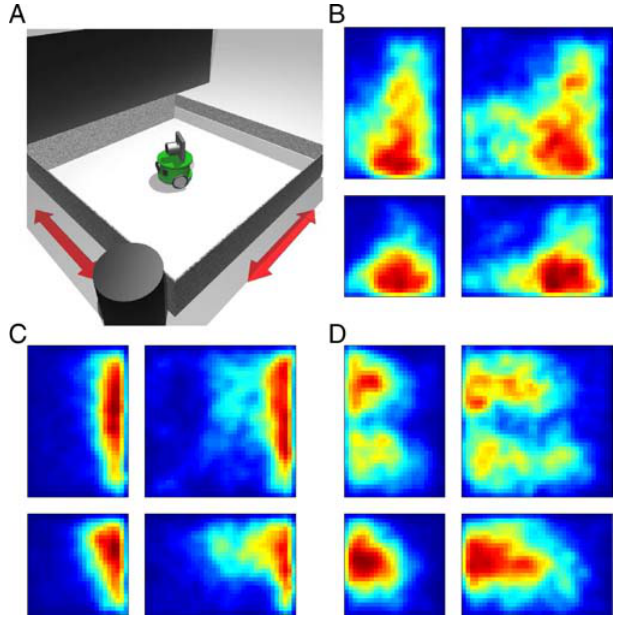
(A) The virtual robot environment consists of a square arena of comparable relative size to the real-world setup and surrounding objects, e.g., a large wall along one side of the arena and a cylinder next to one of the opposite corners. This environment is stretched along either or both directions indicated by the red arrows by a factor of 1.5. (B–D) Response map of three example units that have been acquired in the original environment—small square, lower left map in (B–D)—and subsequently tested in three variants of the original environment, i.e., stretched along the vertical and/or horizontal directions. For each unit, the intensity scale of all four response maps is normalized to the maximal response of all environments. DOI: